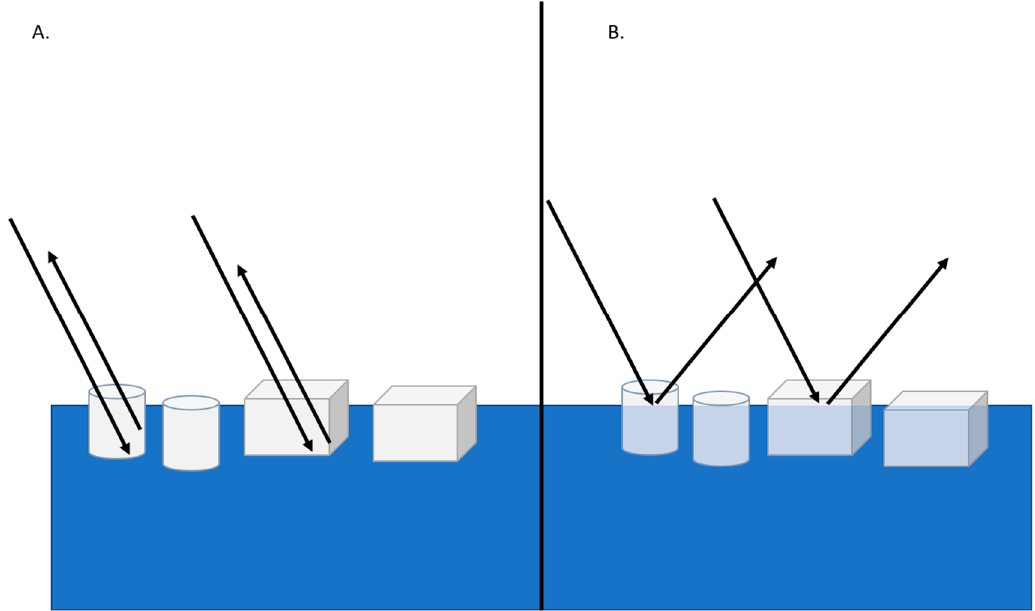
Figure 10. Radar backscatter interacting in different scenes. ( A ) ‘Indentation’ Scattering is a change in backscatter from ‘dry’ plastics that are partially submerged with no layer of water on top but are producing indentations in the water. ( B ) Plastics with water filling with void space where ‘indentation’ scattering is created, causing an increase in specular scattering.